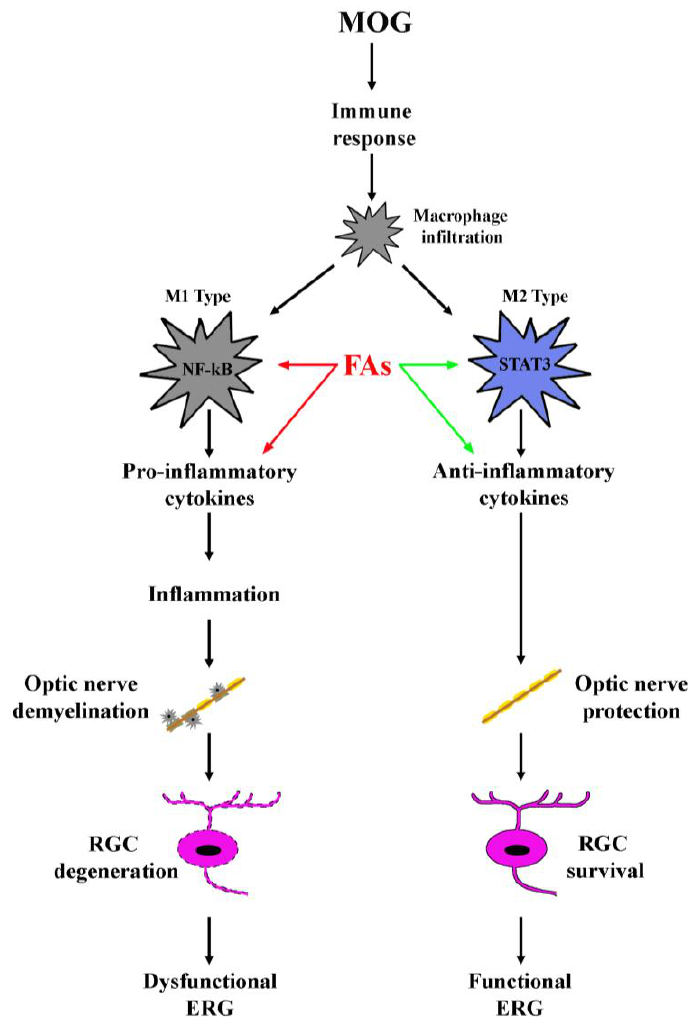
Figure 6. Schematic diagram depicting the role of FAs in the EAE model. MOG induces an immune response resulting in macrophage infiltration. Infiltrating macrophages can acquire distinct phenotypes M1 or M2, of which, M1 produces pro-inflammatory cytokines and activates inflammatory processes, while M2 plays a role in the blockade of inflammation and promotes tissue repair. Both FAs-induced inhibition of M1 phenotype (red arrows) and FAs-induced activation of M2 phenotype (green arrows) concur to prevent inflammatory processes in the retina thus hampering optic nerve damage and retinal ganglion cell (RGC) death, events that both participate to counteract electroretinogram (ERG) dysfunction.